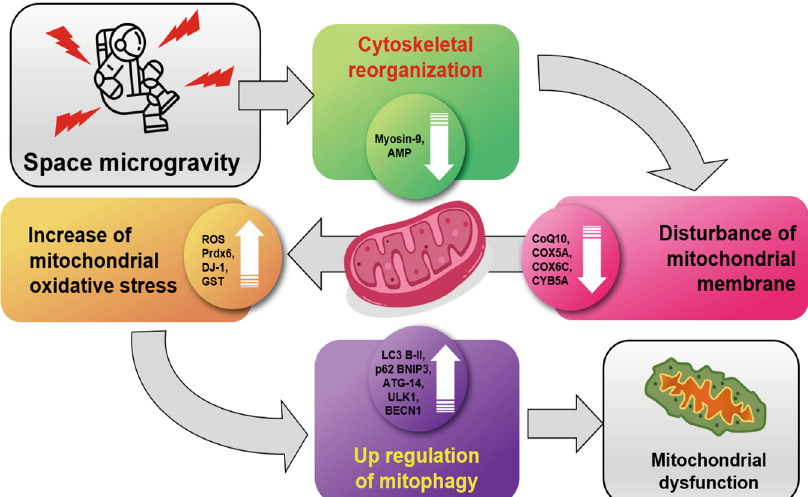
Fig. 2 Space microgravity and mitochondrial dysfunction. Space microgravity causes cytoskeletal reorganization with the decrease of muscle markers such as Myosin-9 and AMP. Cytoskeletal disruption affects mitochondrial membrane with the decrease of antioxidant factors (CoQ10, COX5A, COX6C, and CYB5A) and the increase of mitochondrial oxidative stress that triggers mitophagy and reduces mitochondrial content and dysfunction. (Copyright of spaceman icon was purchased from The Noun Project, Inc., CA, https://thenounproject.com/term/spaceman/